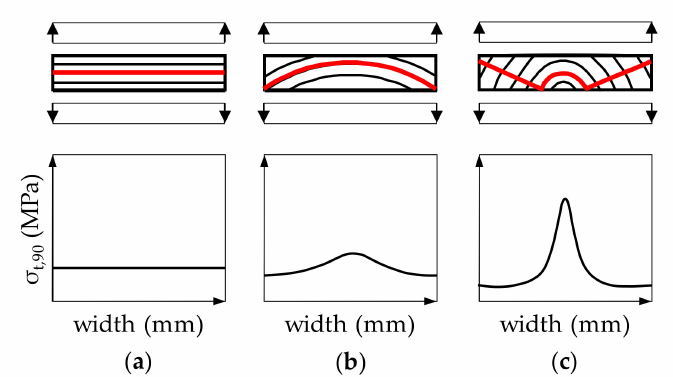
Figure 10. (below) qualitative distributions of tensile stresses perpendicular to the grain in the horizontal center line and (above) the corresponding annual ring patterns and qualitative fracture lines (in red) in lamella cross sections with ( a ) infinite, ( b ) large and ( c ) small radial distance to the pith; see also Dill-Langer